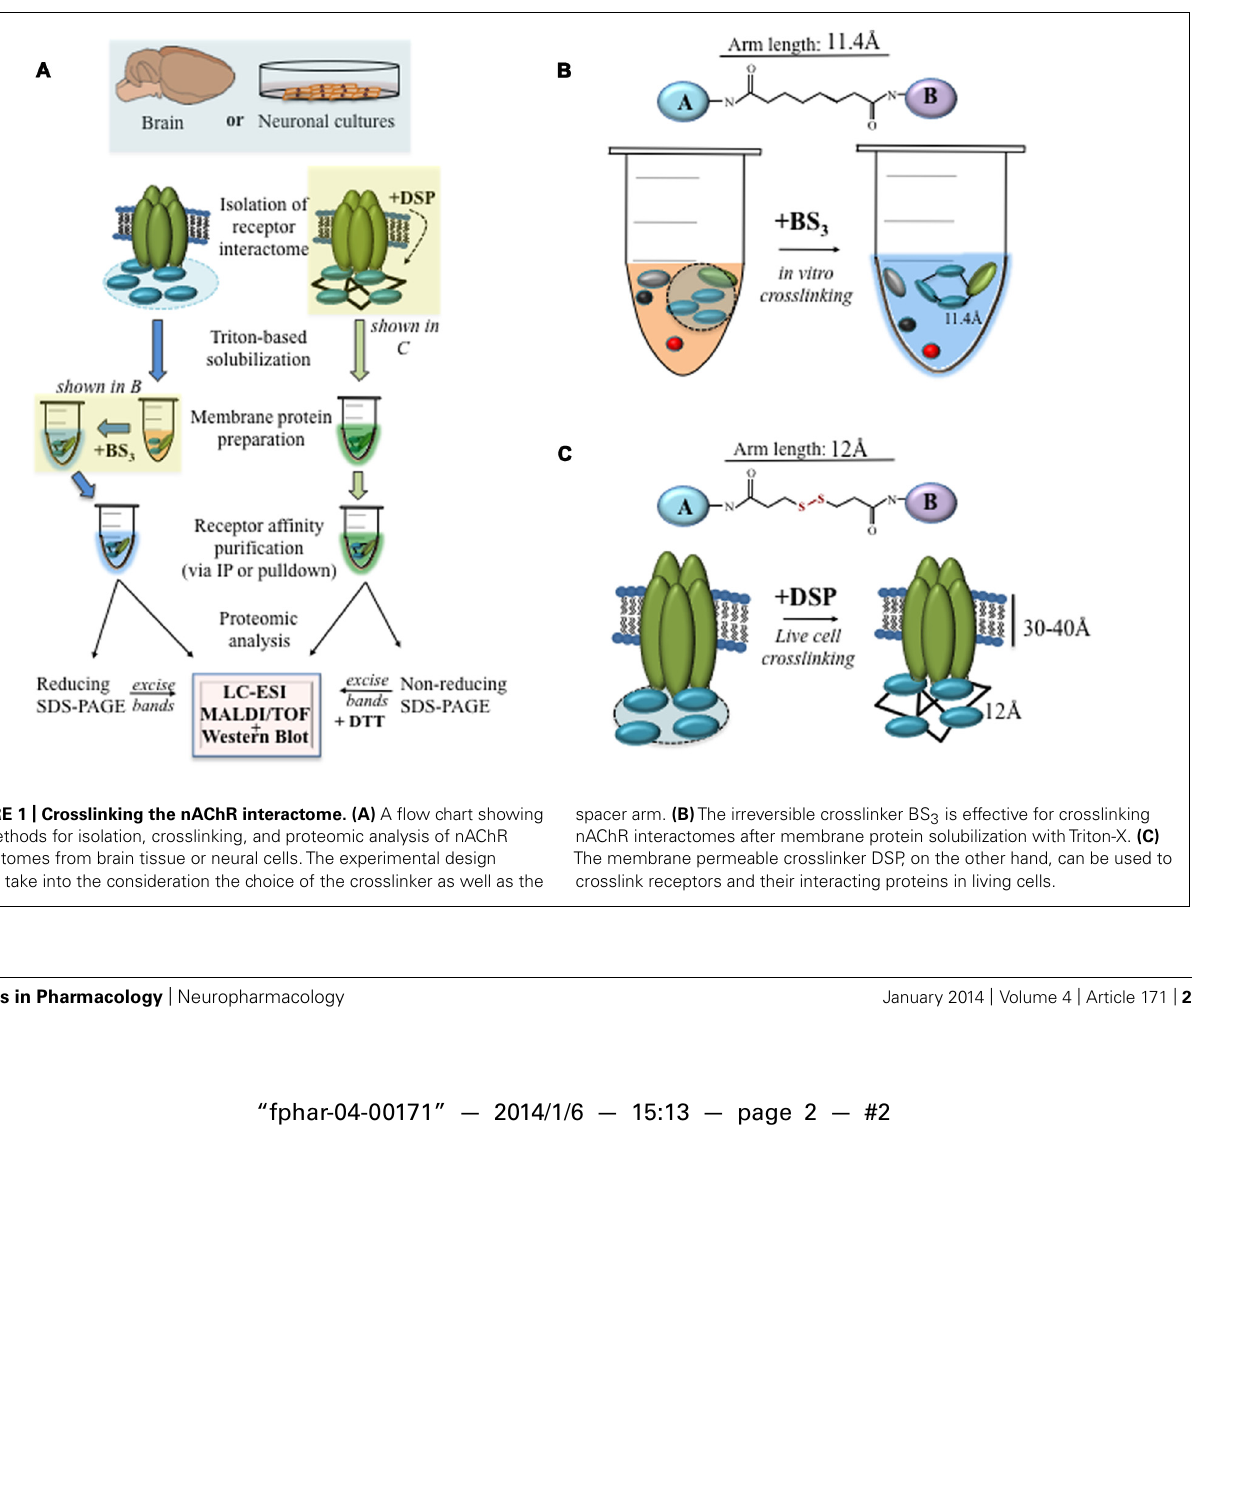
FIGURE 1 | Crosslinking the nAChR interactome. (A) A flow chart showing the methods for isolation, crosslinking, and proteomic analysis of nAChR interactomes from brain tissue or neural cells.The experimental design should take into the consideration the choice of the crosslinker as well as the